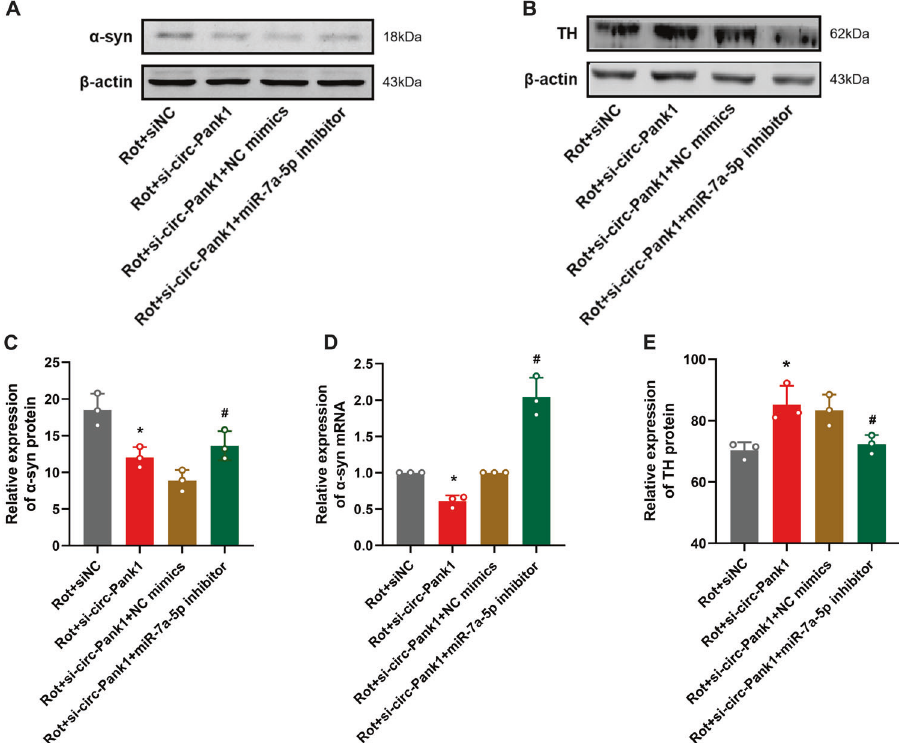
Fig. 5 Circ-Pank1 regulates the dopaminergic neuron damage by targeting miR-7a-5p/ α -syn. After si-circ-Pank1 and miR-7a-5p inhibitors and corresponding controls were transferred to the MN9D cell model treated with rotenone ( n = 3), Western blot analysis of α -syn and TH protein levels ( A – C , E ). qRT – PCR detects the level of α -syn mRNA ( D ). Data are presented as mean ± SD. * P < 0.05, ** P <